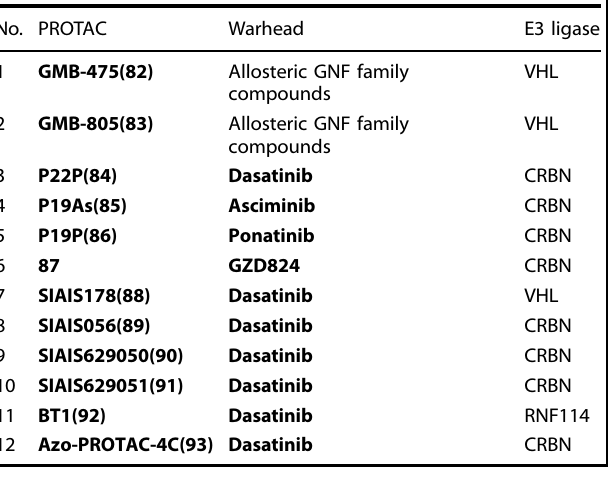
Table 4. The summary and comparison of PROTACs targeting BCR-